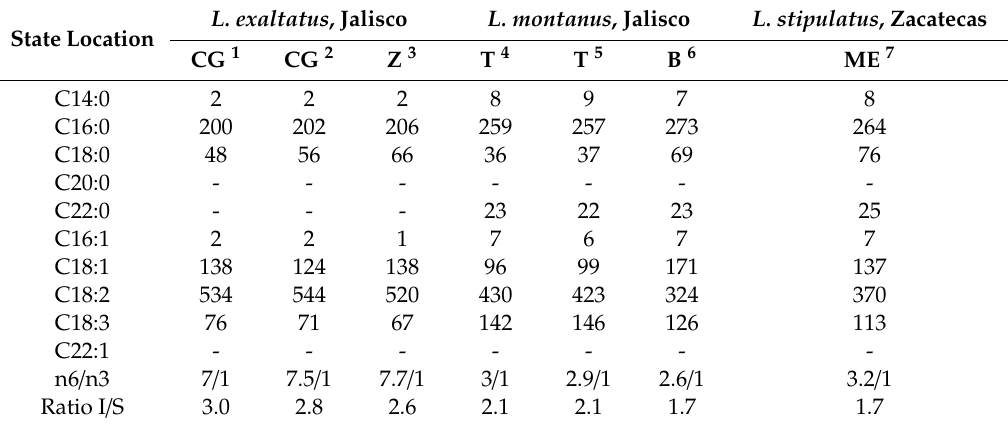
Table 10. Saturated and unsaturated fatty acid content (g / kg) of wild lupin, collected at several locations of Jalisco and Zacatecas states in